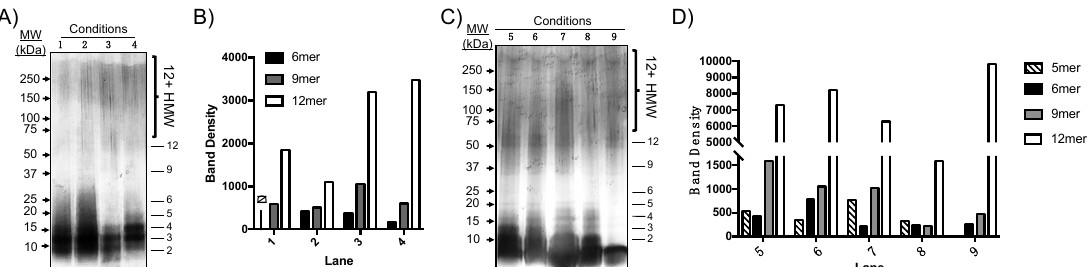
Figure 4. Rapid screening of oligomer growth conditions for A β (M1–40) using PICUP and SDS-PAGE analyses. ( A ) Silver-stained SDS-PAGE gel of A β (M1–40) oligomers incubated under conditions 1–4.